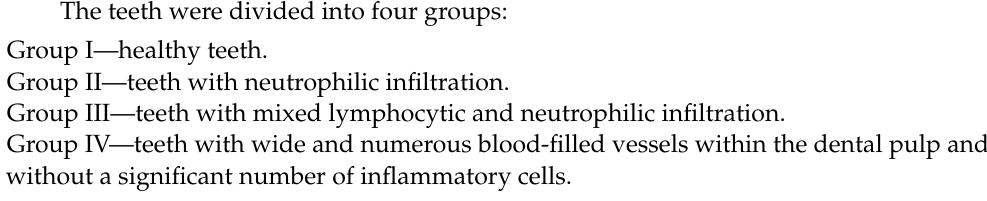
Table 1. The number of teeth used for examinations. Examinations Healthy Teeth [ n ] Carious Teeth [ n ] Histological under light microscope 5 Immunohistochemical Histological under a fluorescence microscope 5 Scanning electron